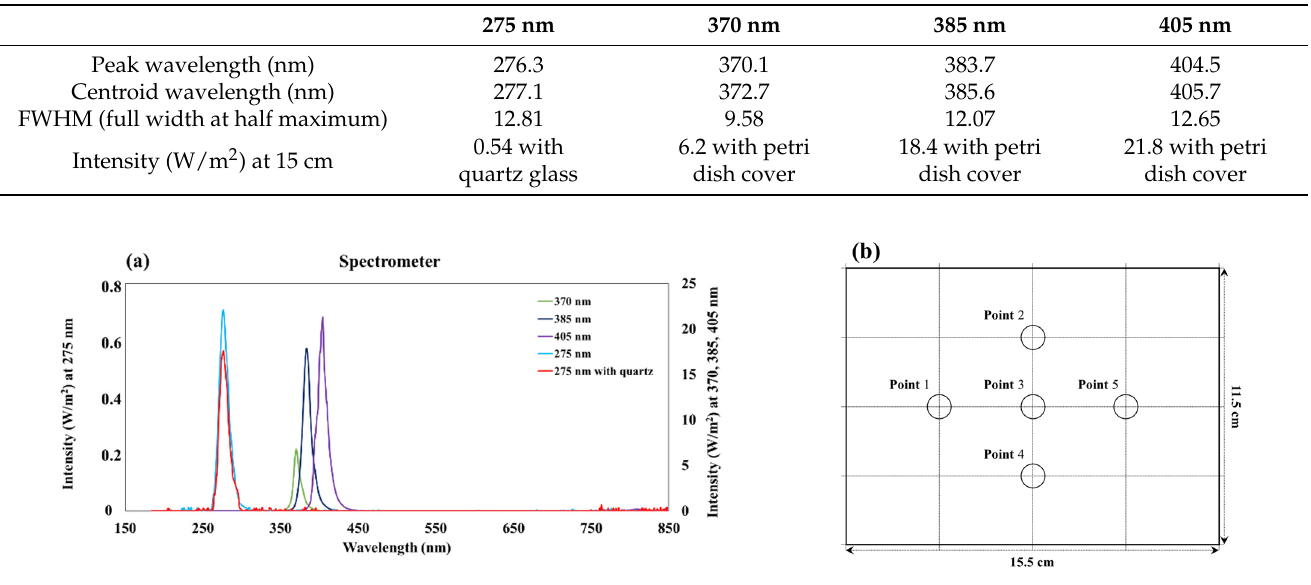
Figure 1. Components of the LED module used in this study. (a) The LED module concept diagram. ( b ) The actual module frame made with a 3D printer. ( c ) Array of the 275 nm LED attached to a heat sink. ( d ) Array of the 405 nm LED attached to a heat sink.